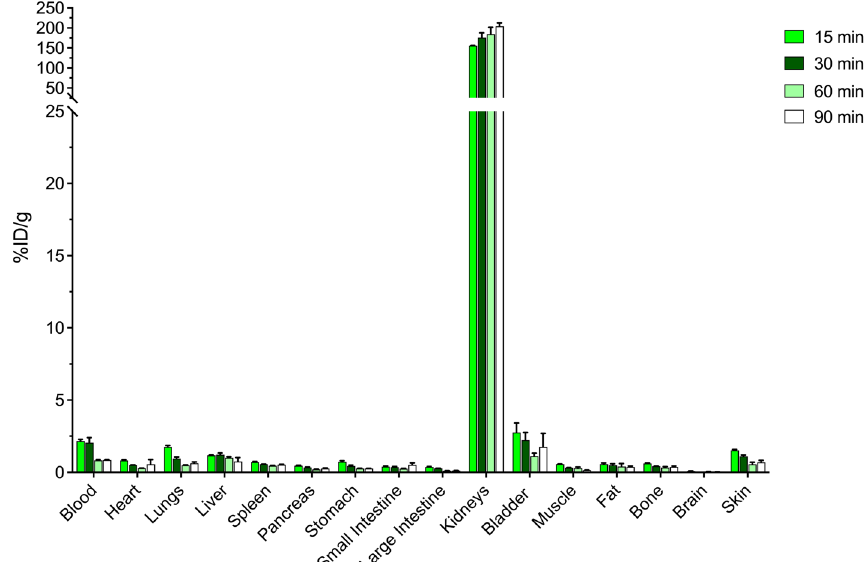
Fig. 2 Biodistribution analysis of [ 68 Ga]Ga-NOTA-anti-CD70 VHH at 15, 30, 60 and 90 min post radiotracer injection. (%ID/g % injected dose/ gram, injected radiotracer dose = time